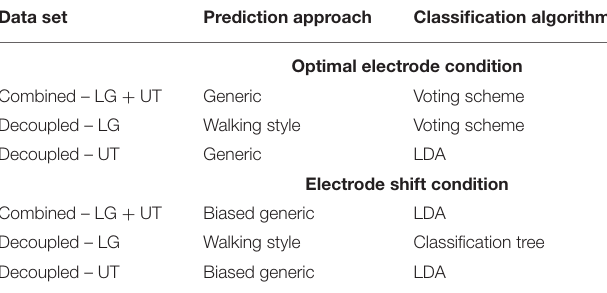
TABLE 2 | Best performing combinations of prediction approach and classification